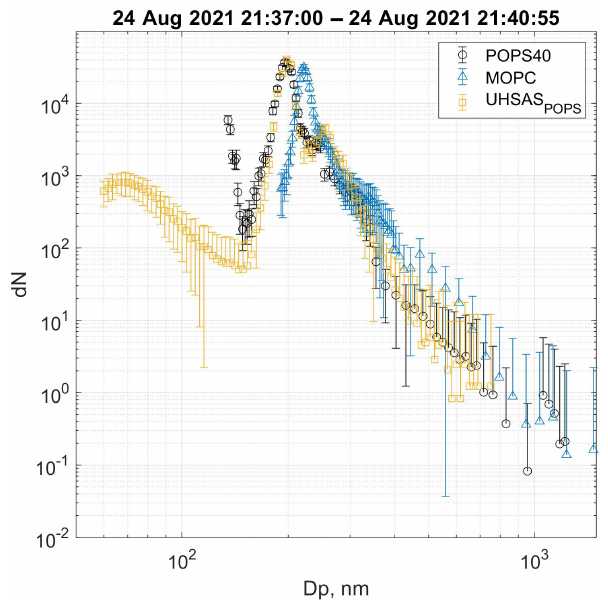
Figure 11. Aerosol size distribution comparison among POPS, MOPC, and UHSAS using 200nm PSL